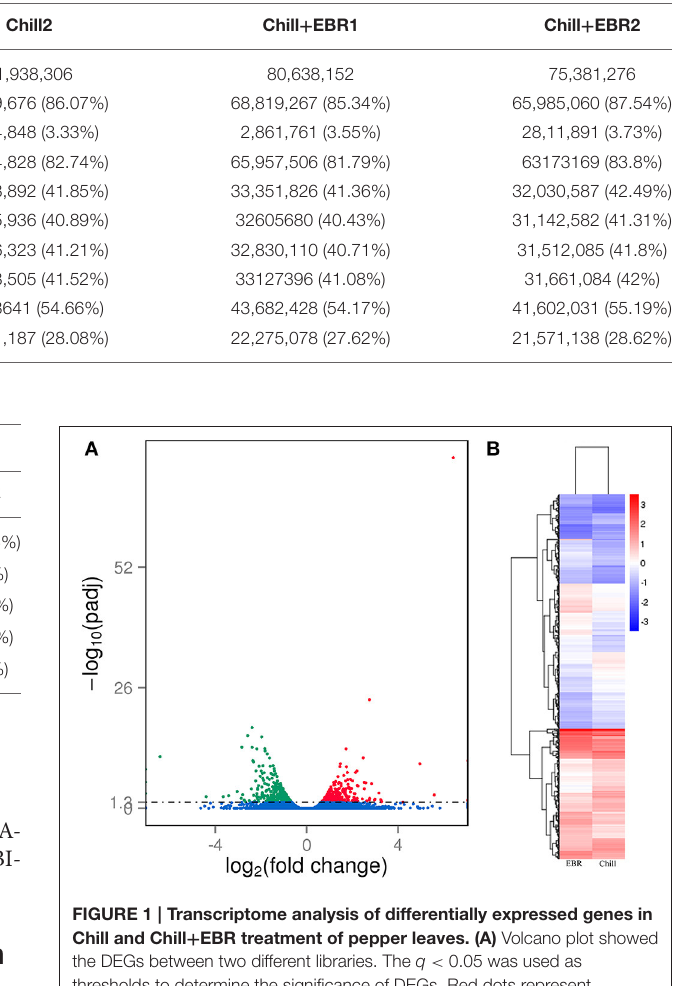
TABLE 2 | Number of reads sequenced and mapped to the pepper genome.